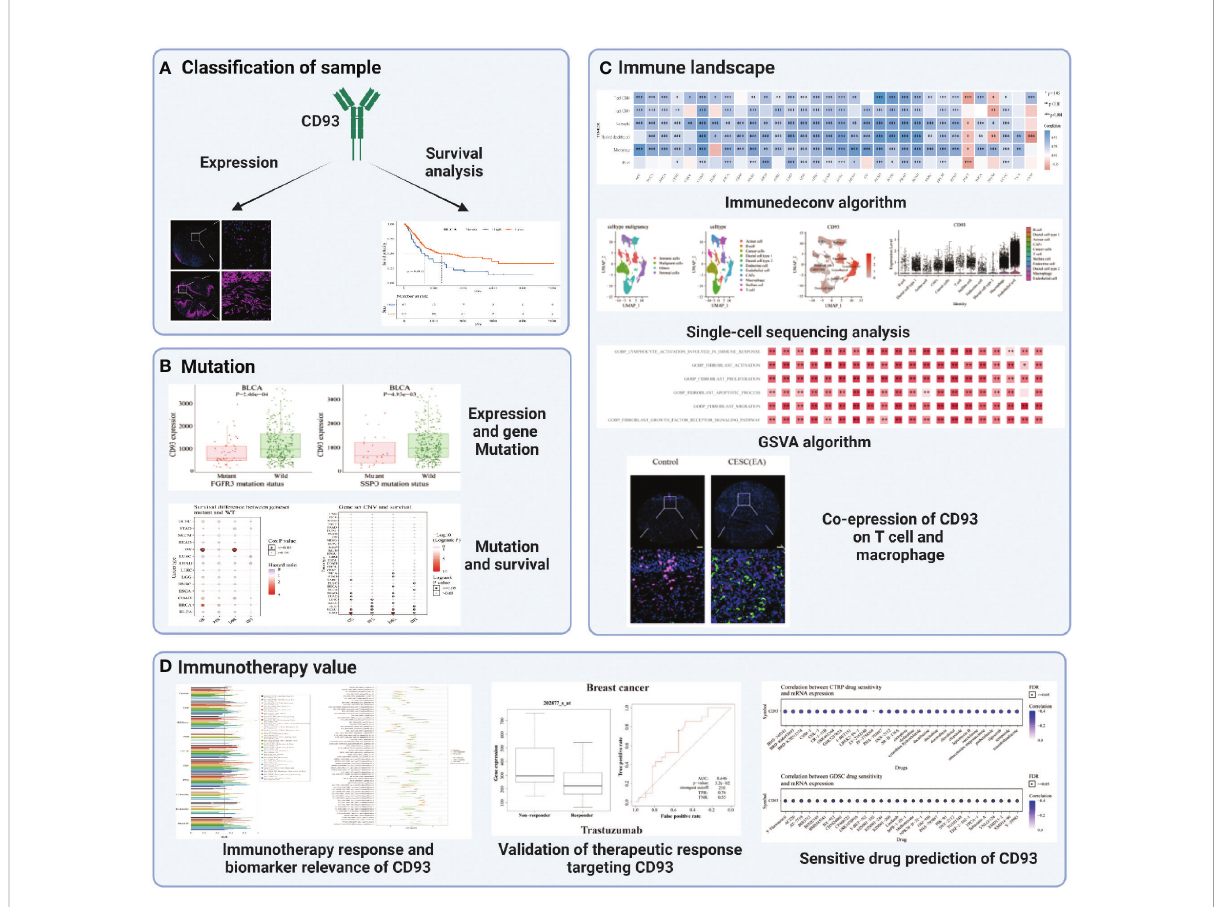
FIGURE 1 The fl ow chart of this study. *p < 0.05, **p < 0.01, ***p <